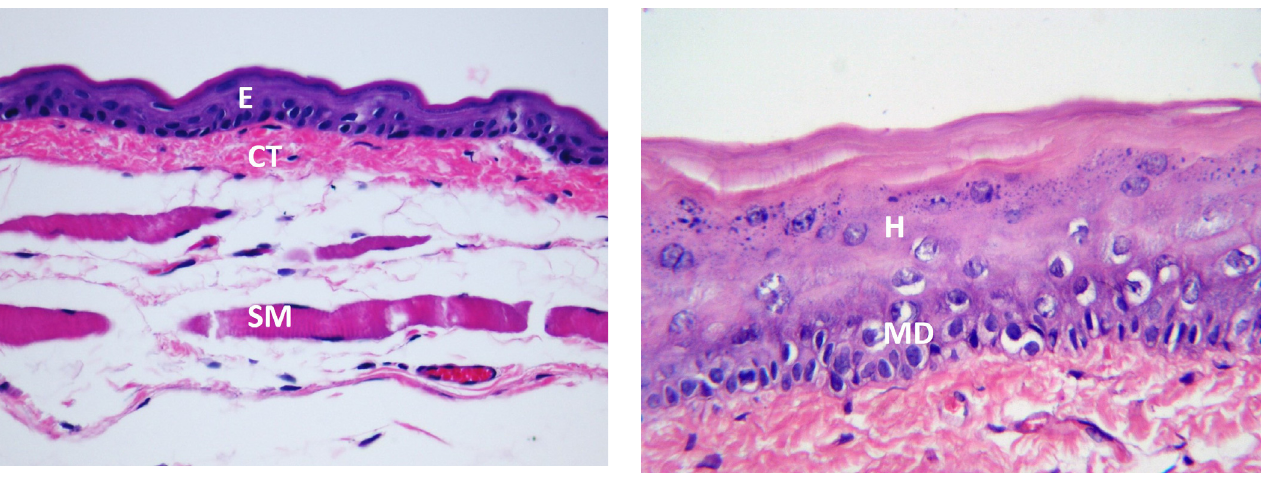
Fig. 4. Shows hematoxylin and eosin-stained cheek pouch section from an animal treated for 6 weeks with 7,12-dimethylbenza[a] anthracene (DMBA) followed by thymoquinone for 6 weeks. Epithelial hyperplasia (H) and mild dysplasia (MD) are evident. Magni fi cation: 40 (cid:1) .